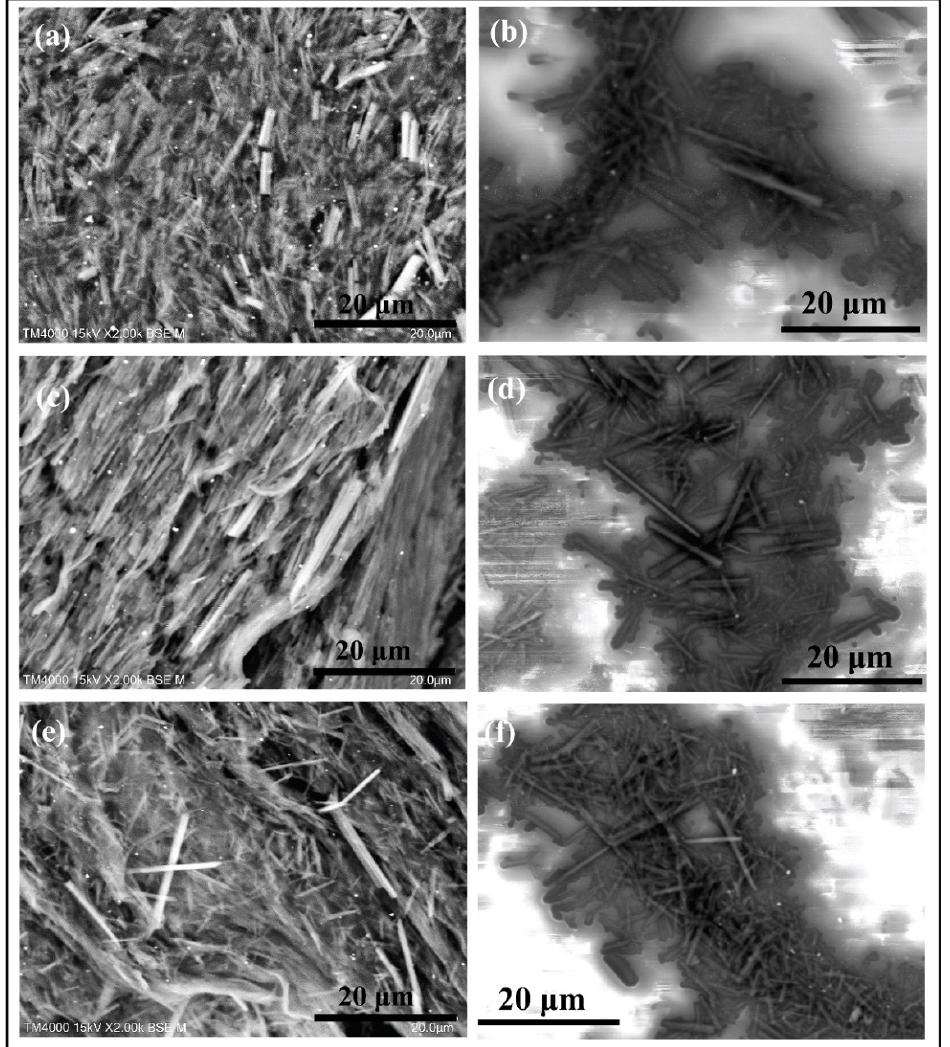
Figure 6. Fractured surface morphology to see the alignment of CNF and CNF surface study of ( a , b ) PP-CNF-1, ( c , d ) PP-CNF-2, and ( e , f ) PP-CNF-3 nanocomposites.